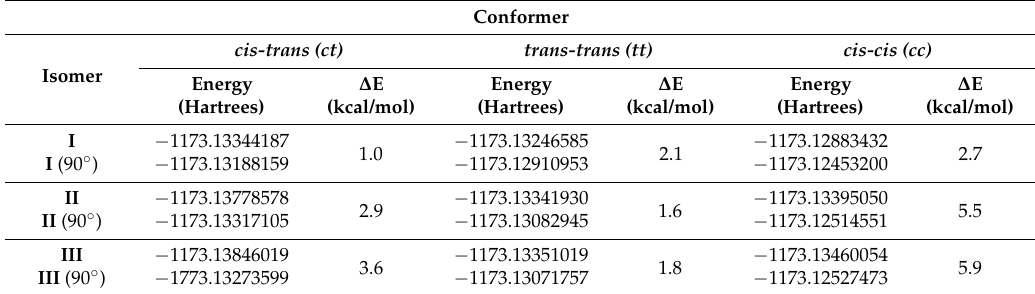
Table 3. Effect of the rotation of the boronic acid group on the conformational energy values of the structures for I – III